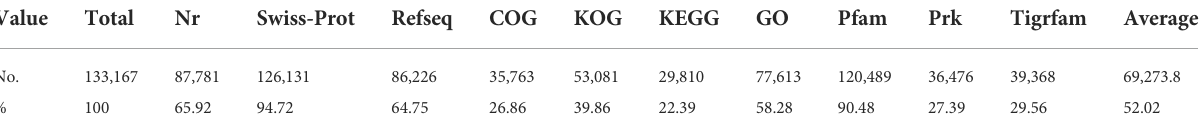
TABLE 2 BLAST hit percentage of annotated coding sequences in different protein databases. Value Total Nr Swiss-Prot Refseq COG KOG KEGG GO Pfam Prk Tigrfam Average